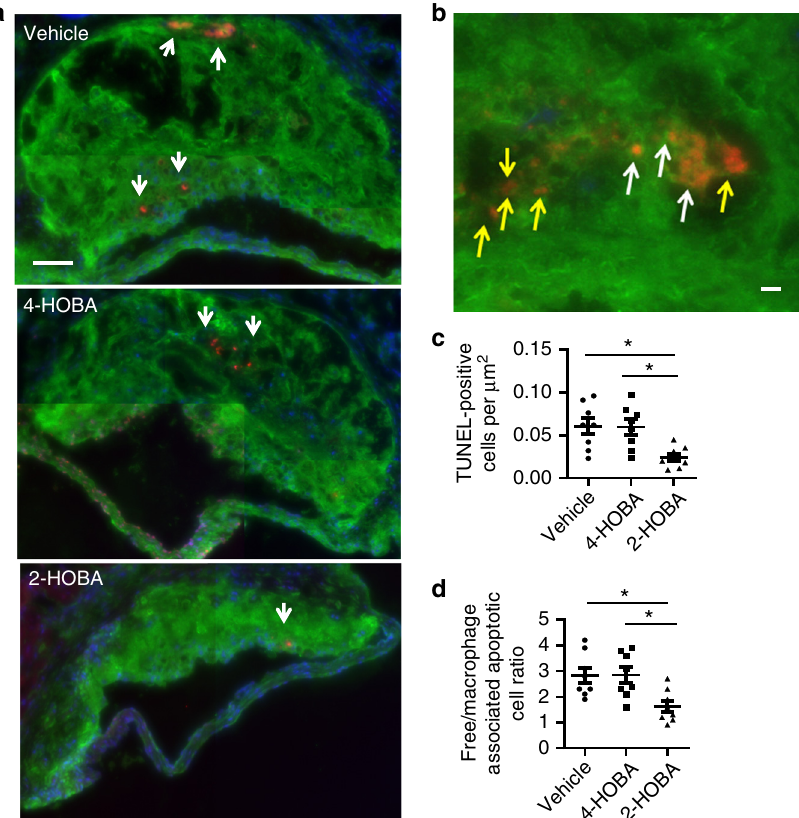
Fig. 4 2-HOBA prevents cell death and increases efferocytosis in atherosclerotic lesions of Ldlr − / − mice. a , c Representative images a and quantitation c of TUNEL-positive nuclei (red) of proximal aorta sections. Macrophages were detected by anti-macrophage primary antibody (green), and nuclei were counterstained with Hoechst (blue). Scale bar = 50 μ m. n = 8 biologically independent mice per group. Data are presented as mean ± SEM. One-way ANOVA with Bonferroni ’ s post hoc test, p values of 2-HOBA vs 4-HOBA and 2-HOBA vs vehicle are *0.0134 and *0.0108. Higher magni fi cation images of the TUNEL staining ( b ) were used to quantitate ( d ) efferocytosis of dead cells in aortic root sections. A representative image taken at a higher magni fi cation shows macrophage-associated TUNEL stain (white arrows) and free dead cells (yellow arrows) that were not associated with macrophages ( b ). Scale bar = 50 μ m. Efferocytosis was quantitated as the free vs macrophage-associated TUNEL-positive cells in the proximal aortic sections ( d ). n = 8 biologically independent mice per group. Data are presented as mean ± SEM. One-way ANOVA with Bonferroni ’ s post hoc test, p values of 2-HOBA vs 4-HOBA and 2-HOBA vs vehicle are *0.0162 and *0.0187. Source data are provided as a source data fi LDL measured by ELISA was reduced by 57% and 54%, respec- tively, in Ldlr − / − mice treated with 2-HOBA (Supplementary Fig. 14B). By comparison, LDL from control and FH subjects